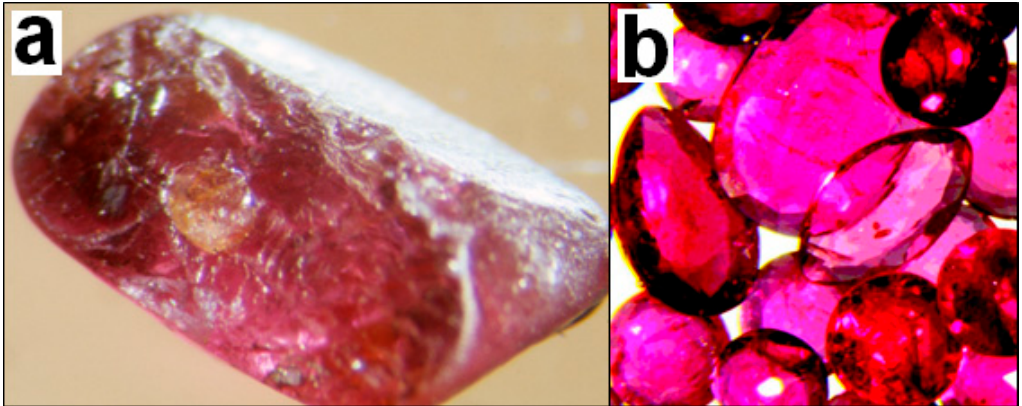
Figure 9. Photos of ruby features from Macquarie-Cudgegong River system alluvial deposits, NSW ( a ) ruby fragment, a few mm across with pyrope garnet inclusion (center). ( b ) Facetted stones of ruby and pink sapphire, up to 3 mm across [47]. Photographer G. Webb, Australian Museum.